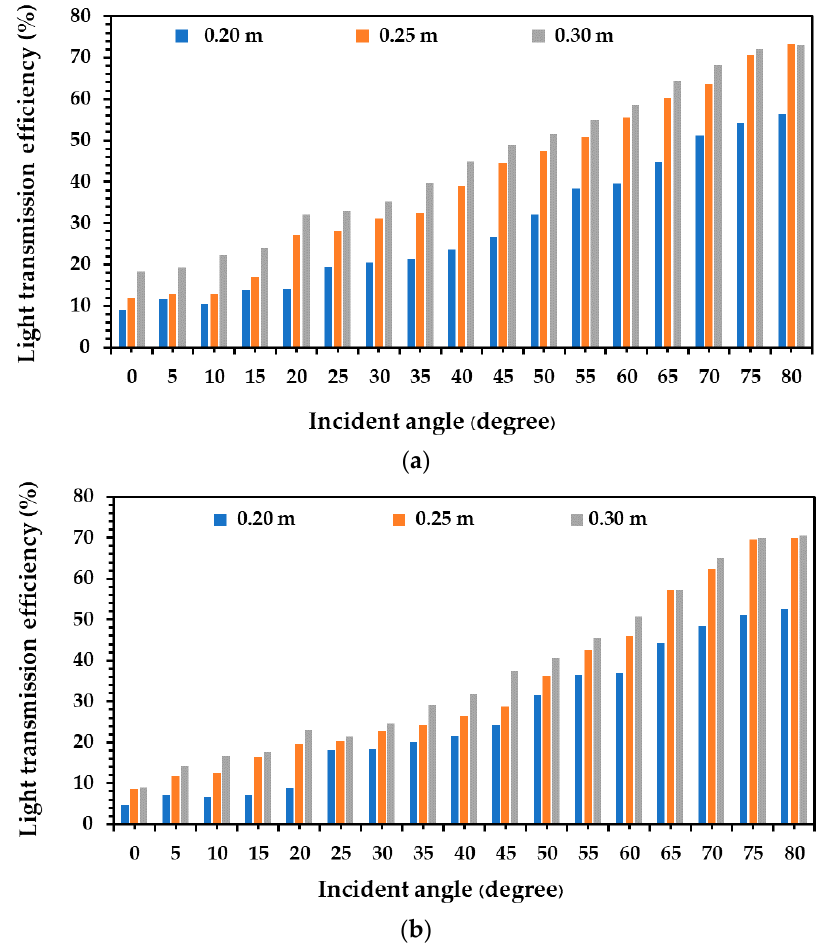
Figure 10. Light transmission performance of ( a ) aluminum alloy tube and ( b ) zinc alloy tube. When using the zinc alloy tube with a diameter 0.20 m and a height of 0.50 m, light transmission increased from 4.7% to 52.5% when the incident light angle increased from 0 ◦ to 80 ◦ . For the diameters of 0.25 m and 0.30 m, the light transmission performance was similar to those of the 0.20 m diameter tube, as illustrated in Figure 10b. Light transmission performance of the zinc alloy tube with a diameter of 0.25 m increased between 8.7% and 69.9%, and that of 0.30 m tube increased between 9.1% and 70.6% with an increase of the incident light angle from 0 ◦ to 80 ◦ . This increase of light transmission performance is achieved from an increase of the incident light angle, demonstrating the reduced number of reflections within the light tube surfaces, which leads to minimal losses of luminous intensity.